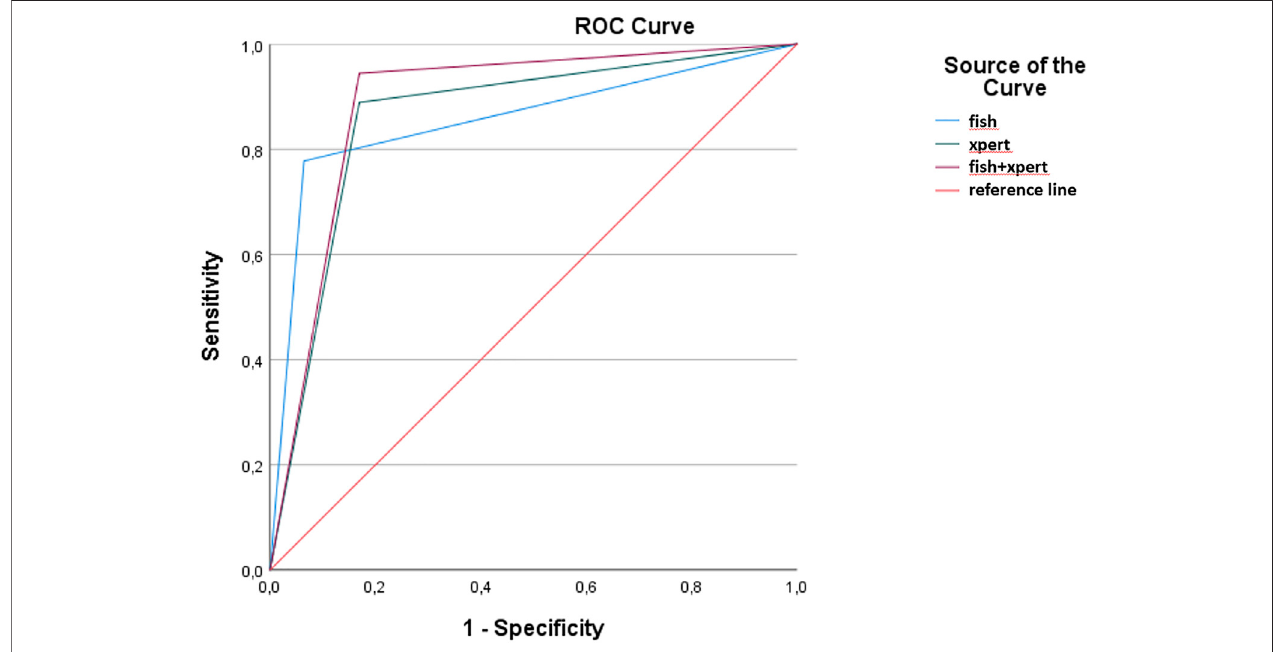
FIGURE1| Receiveroperatingcharacteristiccurvesandareasunderthecurve(AUCs),including95%CIs,werecalculatedforFISH,Xpert,andthecombinationof FISH and Xpert.